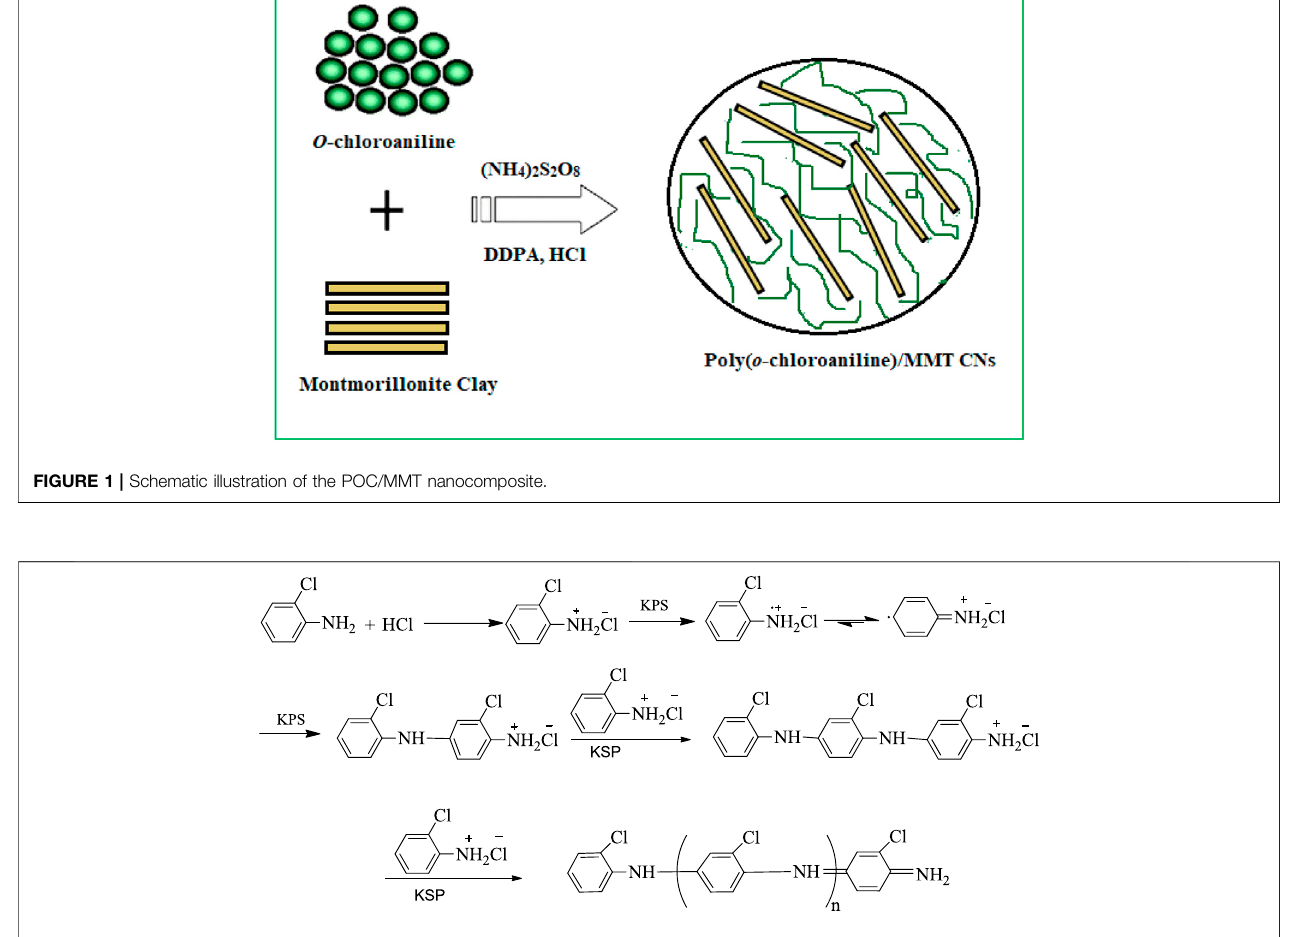
FIGURE 2 | Schematic diagram of polymerization of o